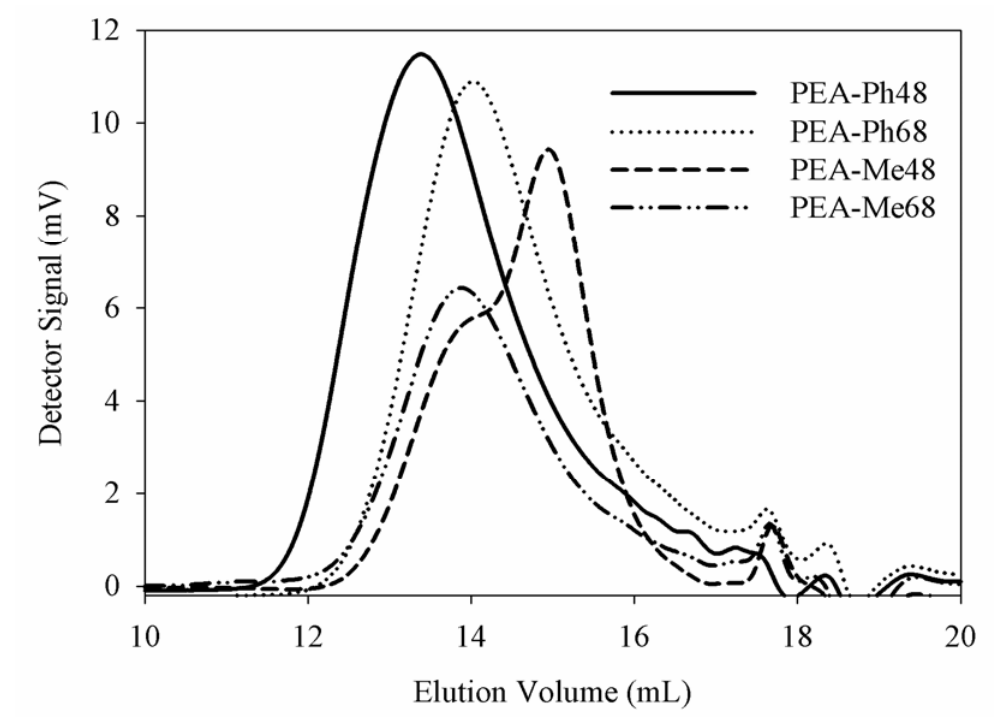
Figure 4. GPC traces of PEAs synthesized from the amino acids L -phenylalanine and L